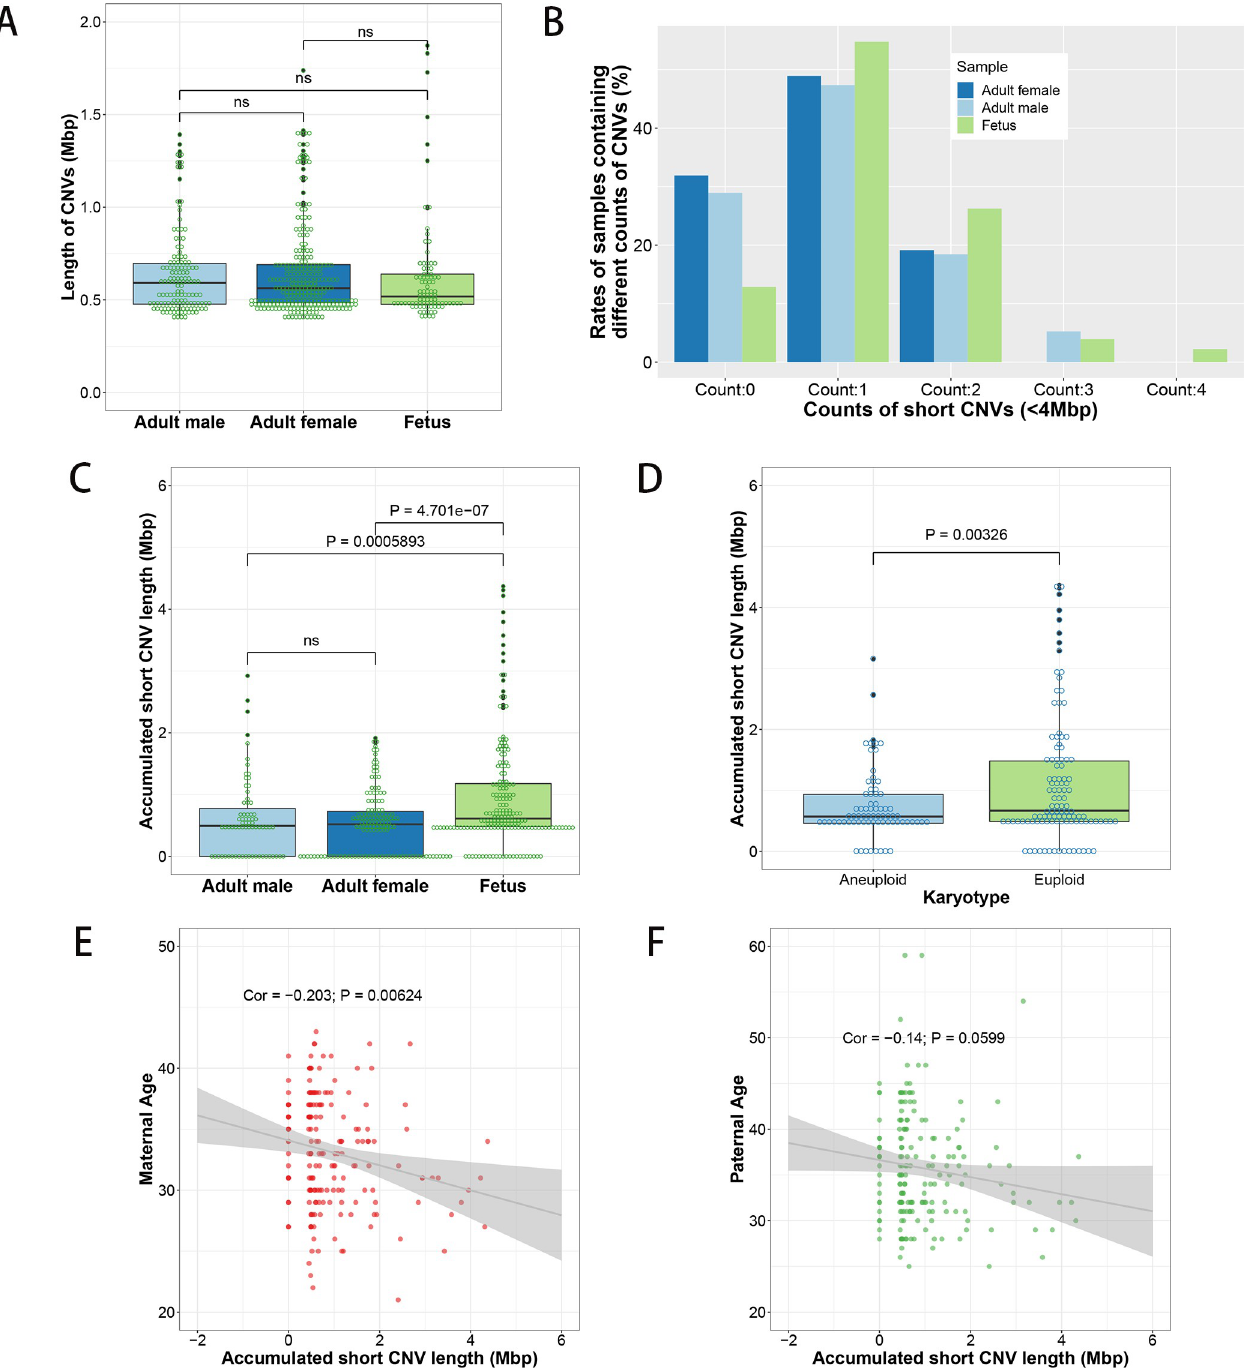
Fig 2. Statistics of short CNVs in ART-aborted fetuses and ART adult patients. (A) Boxplot of lengths of short CNVs of male/female patients and aborted fetuses. (B) Rates of samples containing different number of short CNVs. (C and D) Accumulated lengths of short CNVs in each sample grouped by adult males, adult females and aborted fetuses (C) or by aneuploid and euploid of the aborted fetuses (D). (E and F) The association analysis of accumulated short CNV lengths with maternal ages (E) and paternal ages (F). ‘ns’, P values of t test > 0.05. ‘Cor’, correlation coefficient.